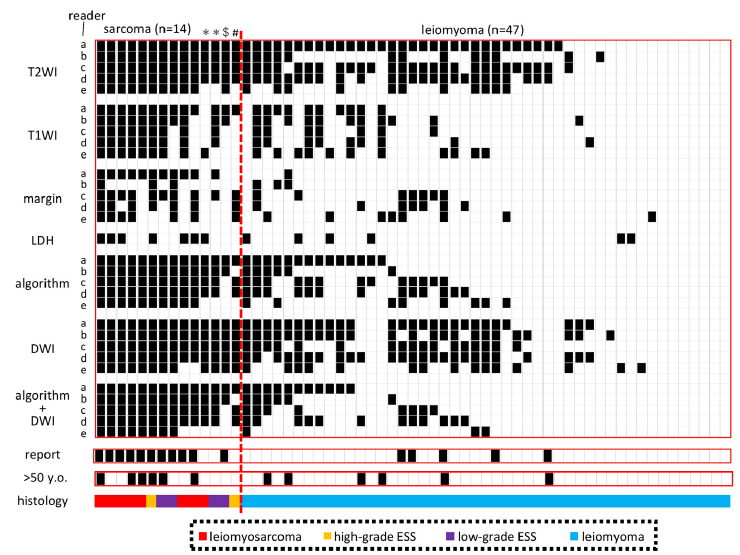
Figure 3. Verification of the reproducibility of image evaluation. We selected sarcoma cases with available DWI from Kindai Cohorts I and II and randomly selected algorithm-positive myomas, high-T2 myomas only, and low-T2 myomas. Algorithm + DWI was determined by taking the DWI into account. The algorithm + DWI was determined by considering the DWI and a positive algorithm but a low DWI is marked as negative in white. >50 y.o., case older than 50 years. ** The patient was followed up in the outpatient clinic for several months before surgery was performed. $ Before surgery, the LDH level was elevated, and both Readers C and D determined it to be algorithmic-positive. # The tumor protruded vaginally, and the sarcoma could be diagnosed preoperatively. Table 4. Percentage agreement between Readers A and B or versus the report.